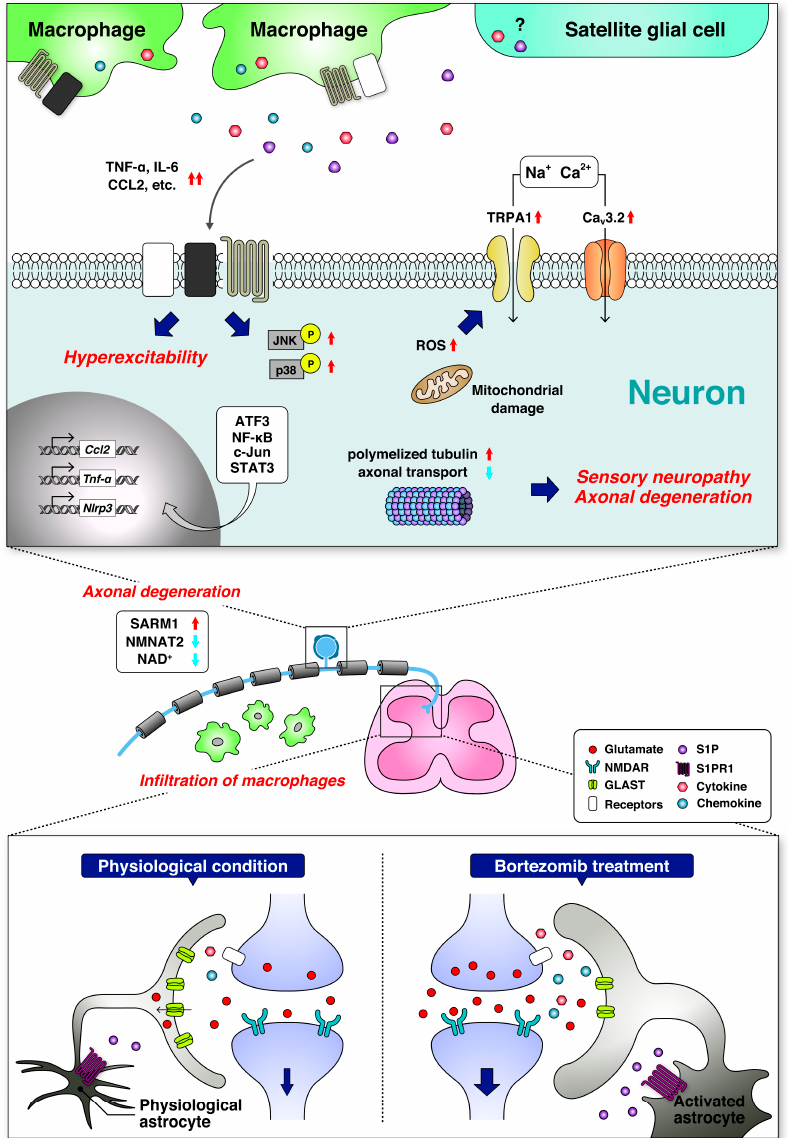
Figure 1. Mechanisms of bortezomib-induced peripheral neuropathy (BIPN). Schematic illustrations show the proposed principal pathways dysregulated by bortezomib in the dorsal root ganglia (DRG) and spinal dorsal horn involving BIPN. In the DRG, bortezomib increases polymerized tubulin and decreases axonal transport. In addition, NAD + levels are decreased in axons, leading to axonal degeneration. Bortezomib impairs mitochondrial function and increases ROS production. Excessive ROS sensitizes TRPA1, resulting in sensory hypersensitivities. Bortezomib also enhances transcriptional programs, which causes inflammatory events and neuronal hyperexcitability. In the dorsal horn, bortezomib dysregulates sphingolipid metabolism, leading to astrocytic activation, neuroinflammation, and disruption of glutamate homeostasis. Finally, these abnormalities result in bortezomib-induced sensory neuropathy. Red up arrows indicate an increase and/or activation, while blue down arrows indicate a decrease and/or inhibition. Abbreviations: activating transcription factor 3 (ATF3); voltage- gated calcium channel 3.2 (Ca v 3.2); CC chemokine ligand 2 (CCL2); glutamate/aspartate transporter (GLAST); interleukin-6 (IL-6); c-Jun N-terminal kinase (JNK); nicotinamide adenine dinucleotide (NAD + ); nuclear factor kappa-light-chain-enhancer of activated B cells (NF- κ B); NOD-like receptor family pyrin domain containing 3 (NLRP3); N-methyl-d-aspartate receptor (NMDAR); nicotinamide mononucleotide adenylyltransferase 2 (NMNAT2); reactive oxygen species (ROS); sterile alpha and toll/interleukin-1 receptor motif-containing 1 (SARM1); sphingosine-1-phosphate (S1P); sphingosine-1-phosphate receptor 1 (S1PR1); signal transducer and activator of transcription-3 (STAT3); tumor necrosis factor alpha (TNF- α ); transient receptor potential ankyrin 1